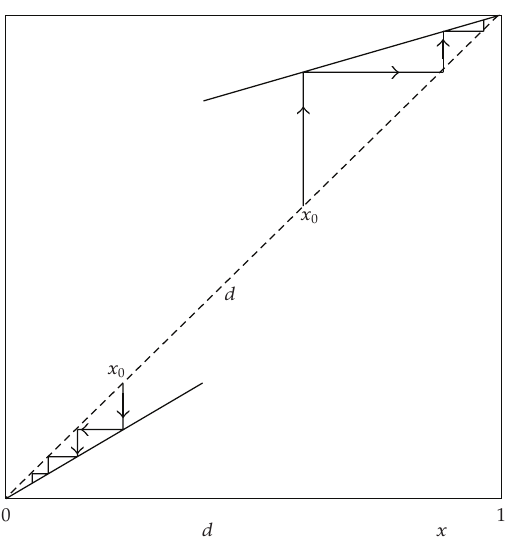
Figure 6: Discontinuous limiting map T 1 with m L (cid:7) 1 − δ A (cid:7) 0 . 6, m R (cid:7) 1 − δ B (cid:7) 0 . 3, d (cid:7) 0 .